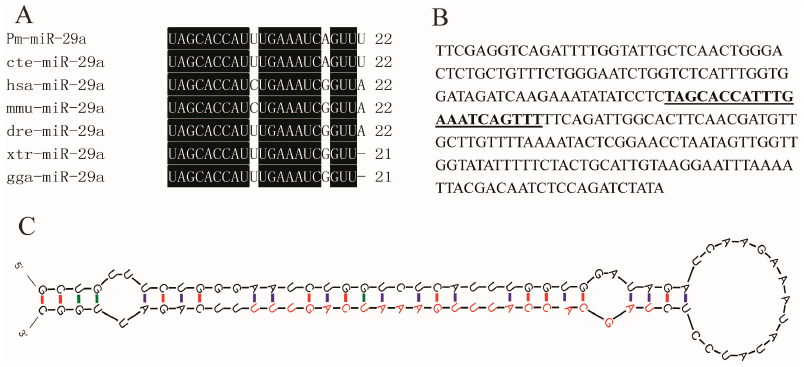
Figure 1. Sequence analysis of Pm-miR-29a. ( A ) Multi-alignment of mature miR-29a of Pinctada martensii (Pm-miR-29a) with that from other species (cte: Capitella teleta; hsa: Homo sapiens; mmu: Mus musculus; dre: Danio rerio; xtr: Xenopus tropicalis; gga: Gallus gallus). The conserved nucleotides in all animals were written in white on a black background; ( B ) Nucleotides surrounding the mature miR-29a, the bold style and underlined nucleotides represented the mature Pm-miR-29a; ( C ) Secondary structure of the precusor Pm-miR-29a analyzed by M-fold, the red nucleotides represented the mature Pm-miR-29a, the green and purple colors respectively means G-U cannot complementary pair but A-U base pair.